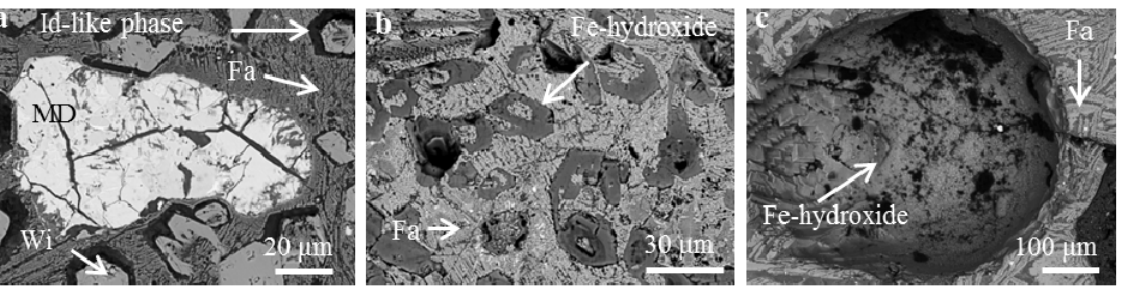
Figure 7. Back-scattered electron images of ( a ) a weakly weathered matte drop and willemite with iddingsite-like phases; ( b ) pseudomorphs of willemite in strongly weathered zone; and ( c ) a pseudomorph of matte drop in strongly weathered zone. Fa: fayalite; Wi: willemite; MD: matte drop; Id: iddingsite.